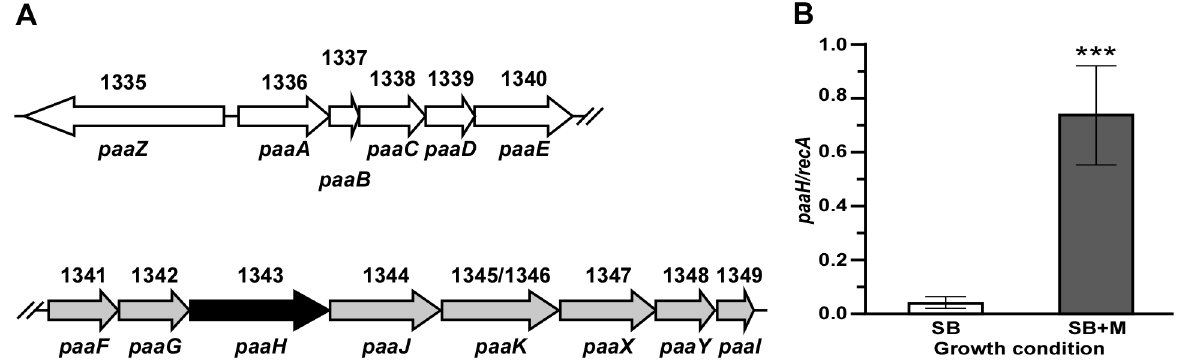
Fig 3. Differential transcription of the paa operon in response to the presenceof mucin. (A) ATCC 19606 T genomiccluster coding for phenylacetate degradation functions. The arrows represent each coding regionand its direction of transcription. The white and grey arrows represent genes constitutively and differentially expressedin responseto the presenceof mucin, respectively.The black arrow indicatesthe gene ( paaH ,A1S_1343)that was used to confirm the mucin-mediatedup-regulation effect by qRT-PCR. Numbers abovethe arrows represent cognate A1S_ gene annotation numbers, and gene names are indicatedbelow each arrow. Coding regionsA1S_1345and A1S_1346are representedas a single coding regionsince potentialnucleotide sequencing errors could have resultedin the annotationof two open readingframes. (B) qRT-PCR analysisof the differentialexpressionof A1S_1343in bacterialcells cultured in SB (white bar) or SB+M (grey bar) performed using nine replicates. Significantly different values ( P (cid:20) 0.001) are identifiedby three asterisks and error bars represent the standarderror of each data